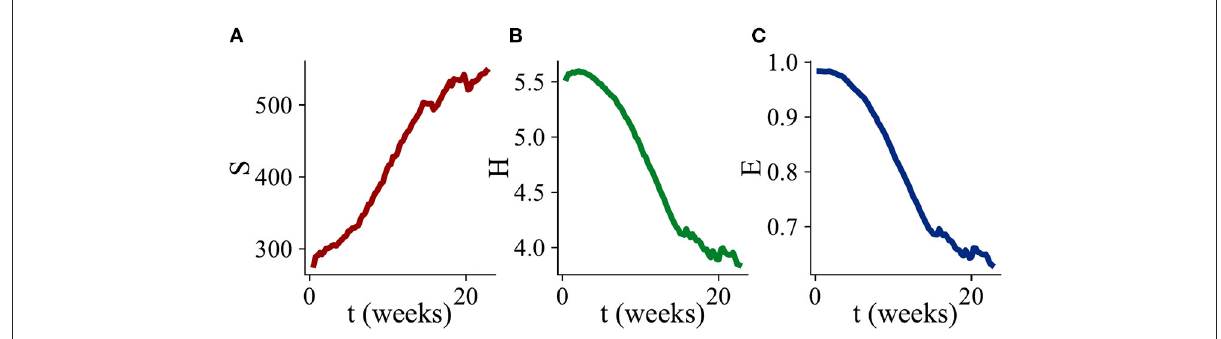
FIGURE3 Changes in alpha diversity during biofilm development. Three diversity indices are computed, defining a “species” as a microbial type with a distinct MIC value. Values of the diversity indices are averaged over all of the simulation runs which exhibited biofilm growth. (A) Average